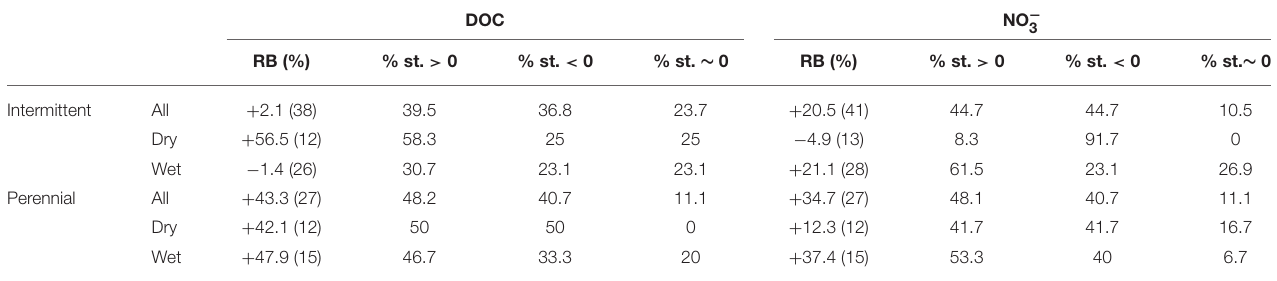
TABLE 3 | Relative bias (RB) between measured and expected export of dissolved organic carbon (DOC) and nitrate (NO − 3 ) during individual storms at the intermittent stream (Fuirosos) and the perennial stream (Font del Regàs).